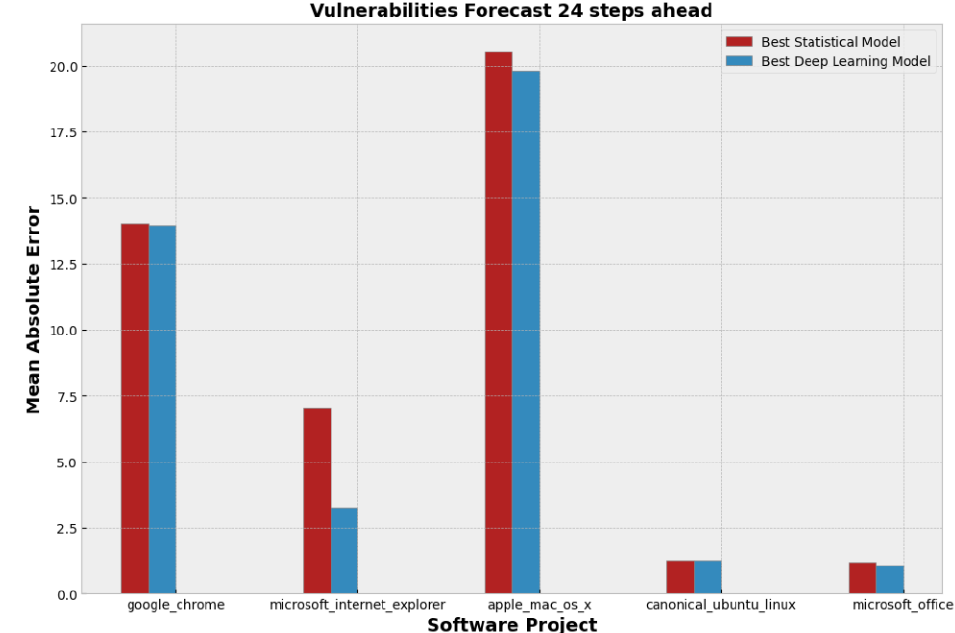
Figure 9. Comparison of the best statistical and deep learning models per project in terms of Mean Absolute Error.